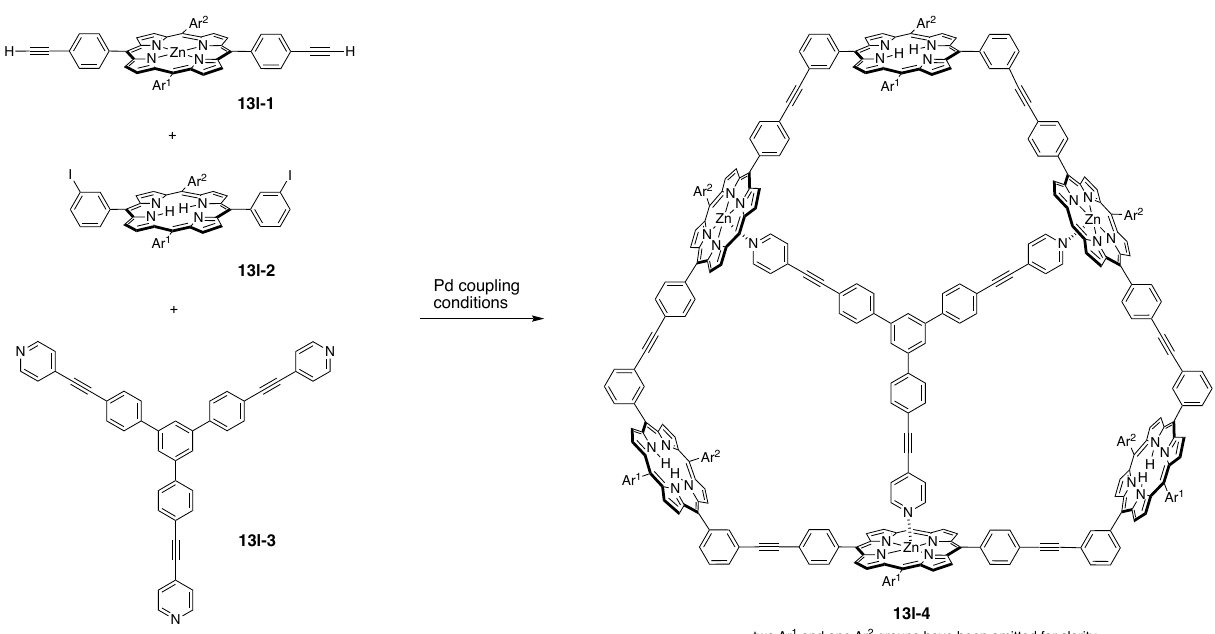
Figure 73. One-flask synthesis of shape-persistent macrocycles encompassing six porphyrins.